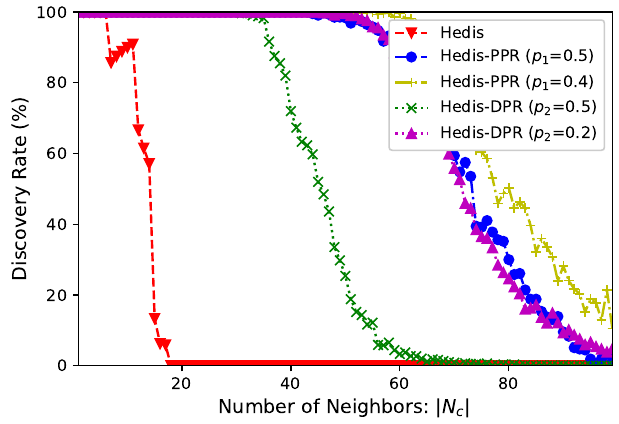
Figure 4. Spear increases discovery rate by incorporating PPR and